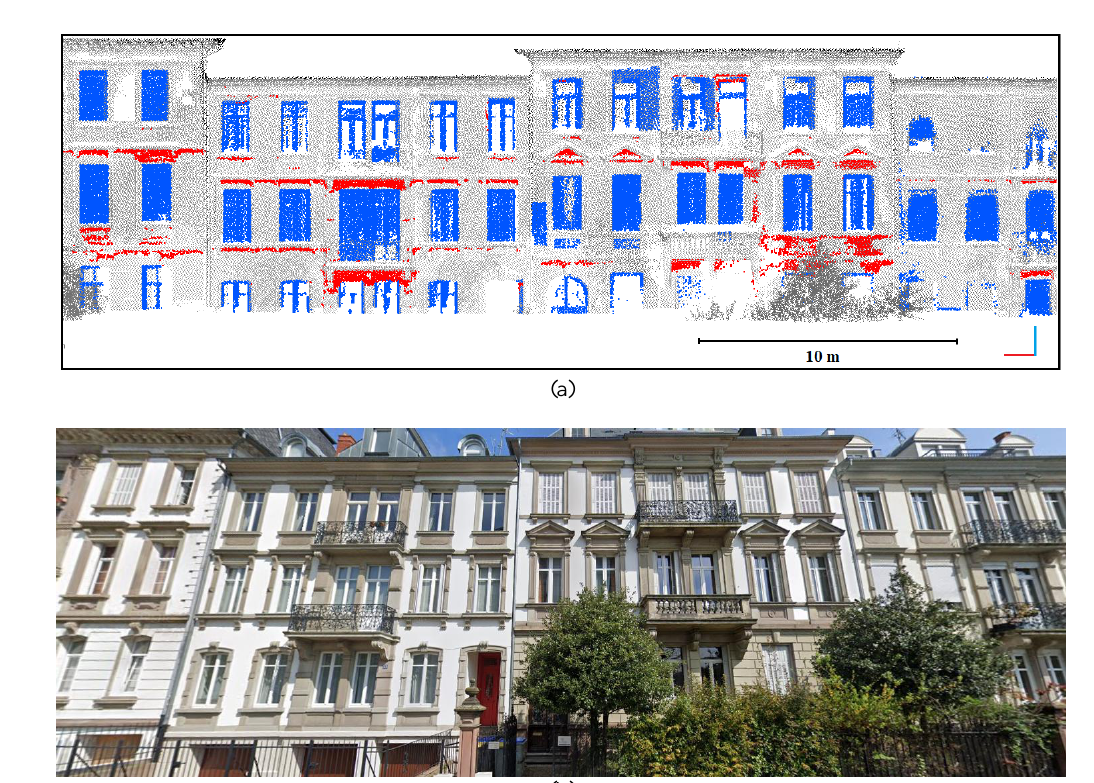
Figure 6: Zoom on the result of the developed approach: (a) windows in blue and thermal bridges in red, (b) photo of the